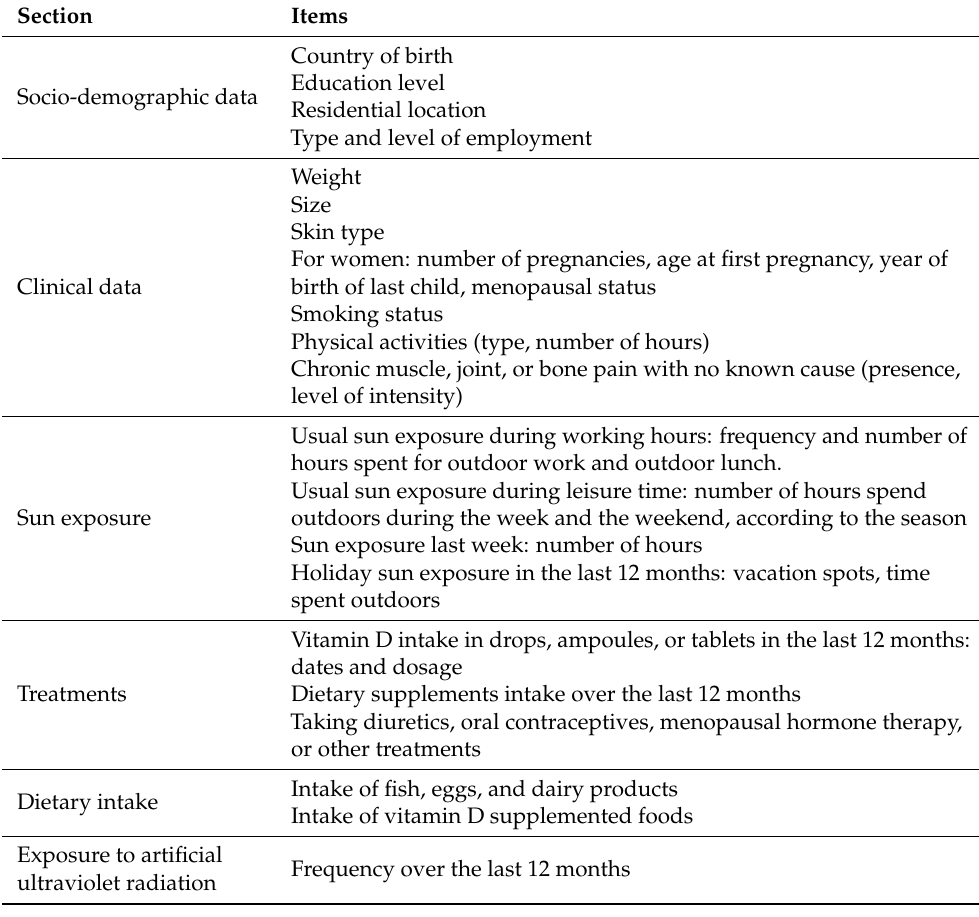
Table A1. Risk Factors for Vitamin D Deficiency Included in the